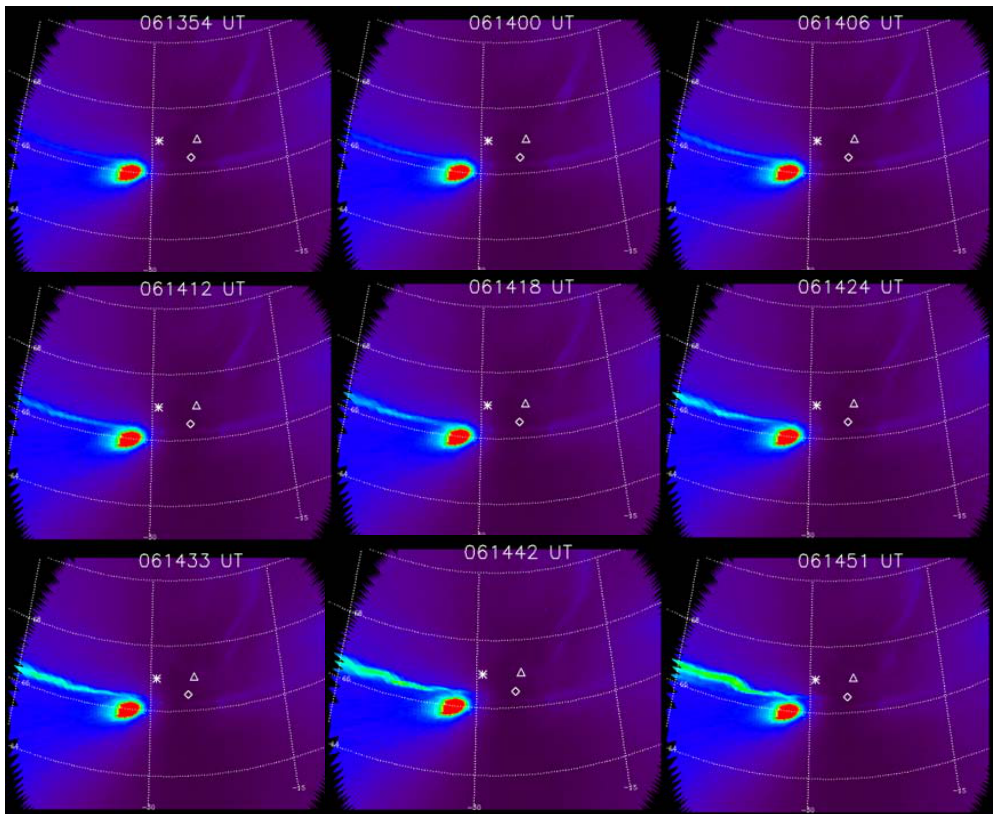
Fig. 1. The auroral images from THEMIS ground GILL ASI observation during 06:13:54–06:14:51UT on 15 February 2008. The probes’ footprints (THA: diamond; THD: triangle; THE: asterisk) are added in each auroral image.